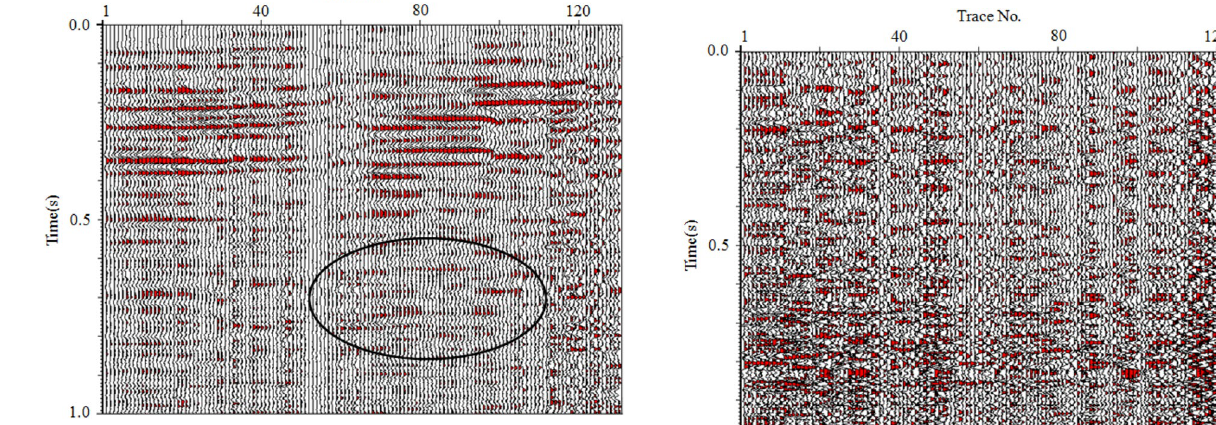
Fig. 8 Reconstruction of Fig. 6b (from 11th to 15th singular values) shows missed